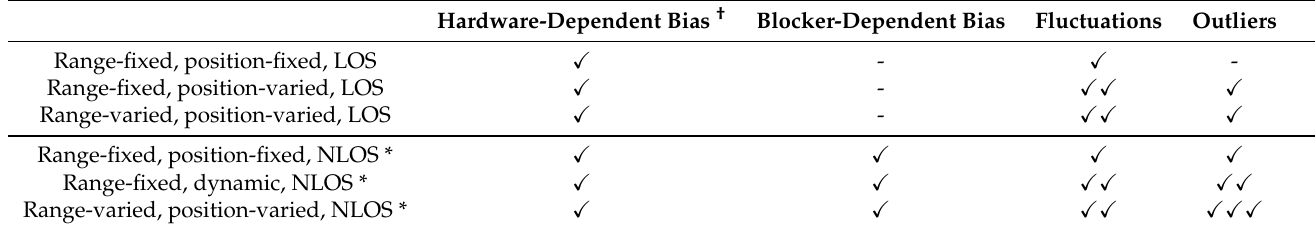
Table 6. Summary of different errors and their impacts on Wi-Fi RTT distance. Hardware-Dependent Bias † Blocker-Dependent Bias